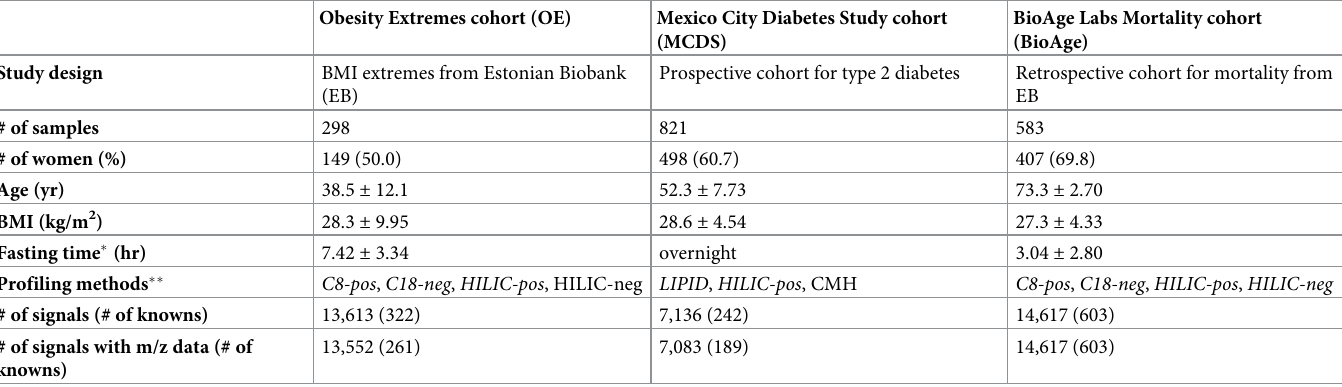
Table 1. Characteristics of study cohorts and corresponding metabolomics